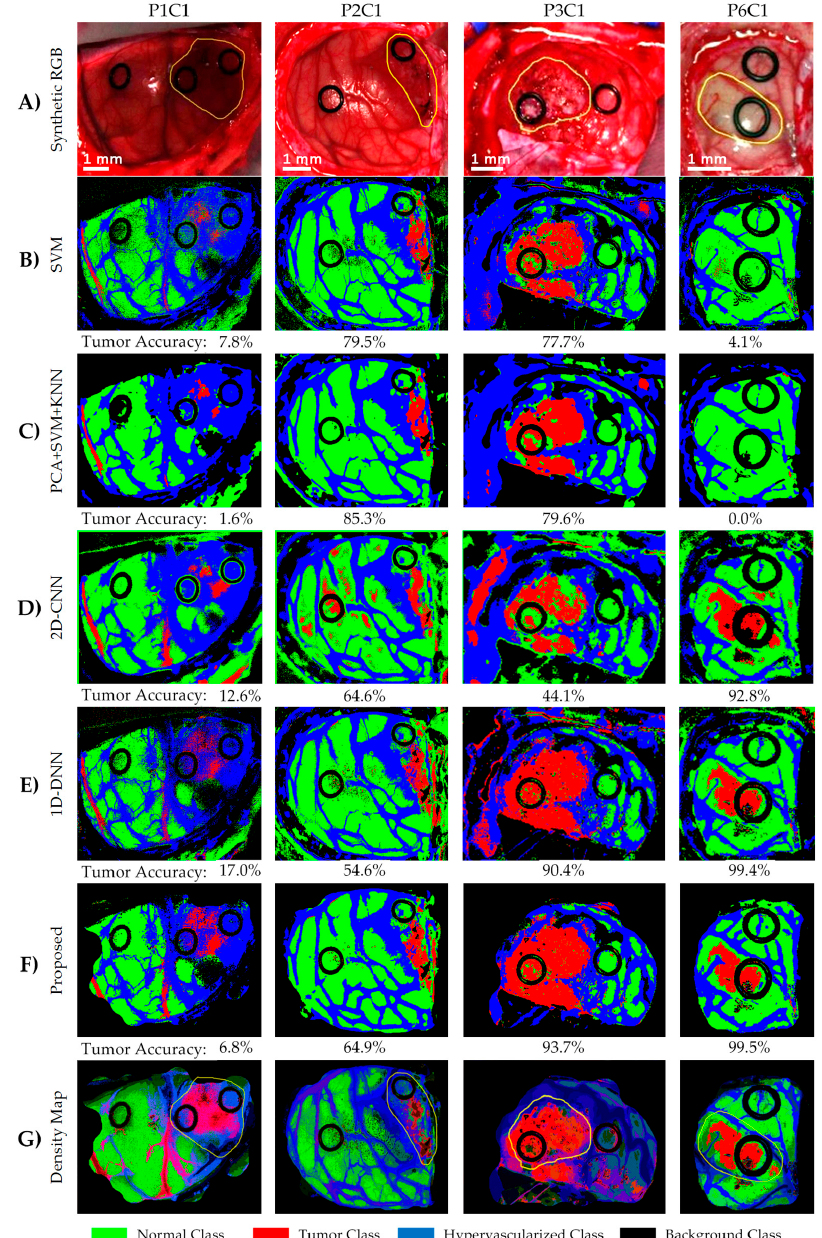
Figure 8. Classification maps of four of the test hyperspectral (HS) images and their respective tumor accuracy below each map. ( A ) Synthetic RGB image with the tumor area surrounded by the yellow lines. ( B – F ) Multiclass classification maps obtained with the support vector machine (SVM), principal component analysis (PCA) + SVM + K-nearest neighbors (KNN), 2D convolutional neural network (2D-CNN), one-dimensional 2D deep neural network (1D-DNN), and the proposed framework, respectively. Normal, tumor, and hypervascularized tissue are represented in green, red, and blue colors, respectively, while the background is represented in black. ( G ) Density maps generated using the surgical aid visualization algorithm with the optimal threshold established for the tumor class. In these maps, the colors have been adjusted depending on the probability values obtained after the majority voting